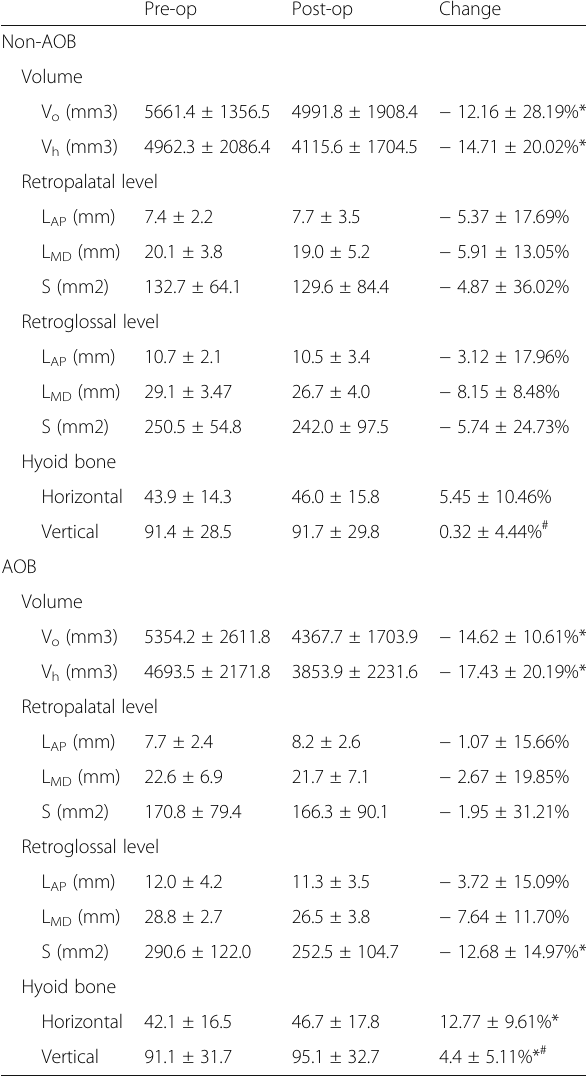
Table 2 Results of pharyngeal airway and hyoid bone position measurements